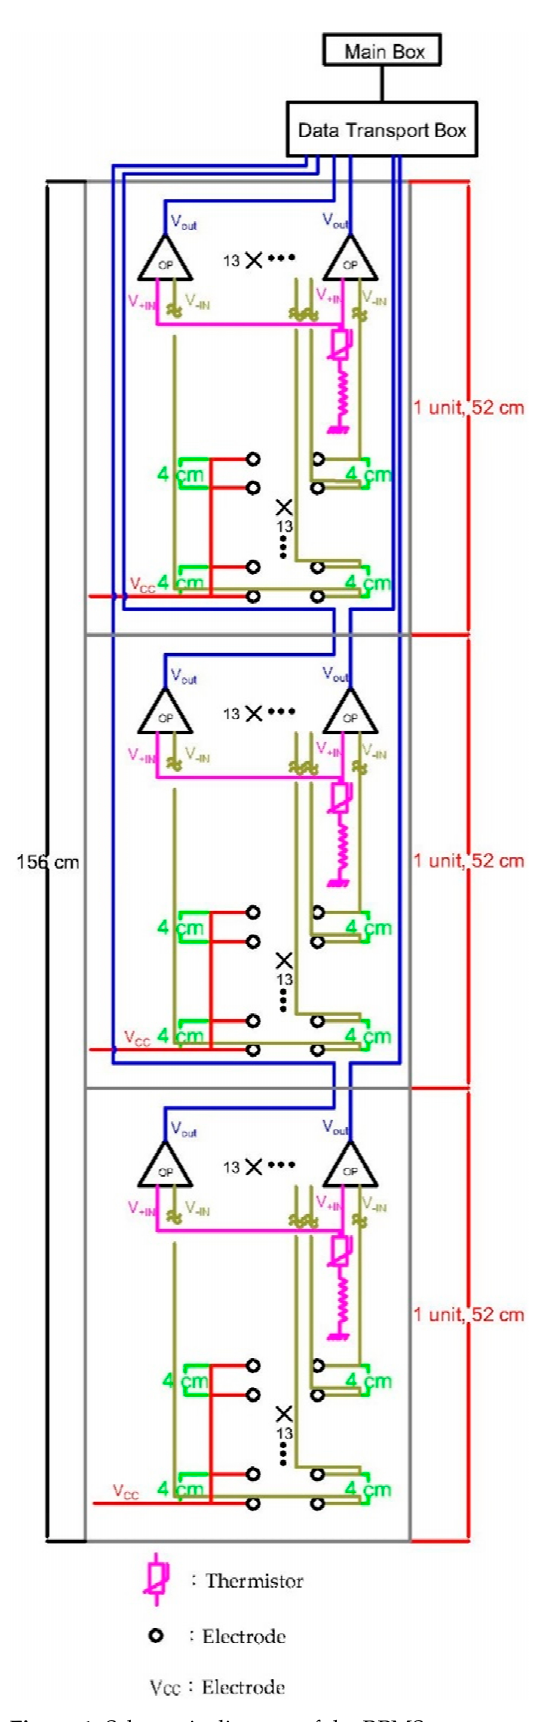
Figure 1. Schematic diagram of the RPMS system.